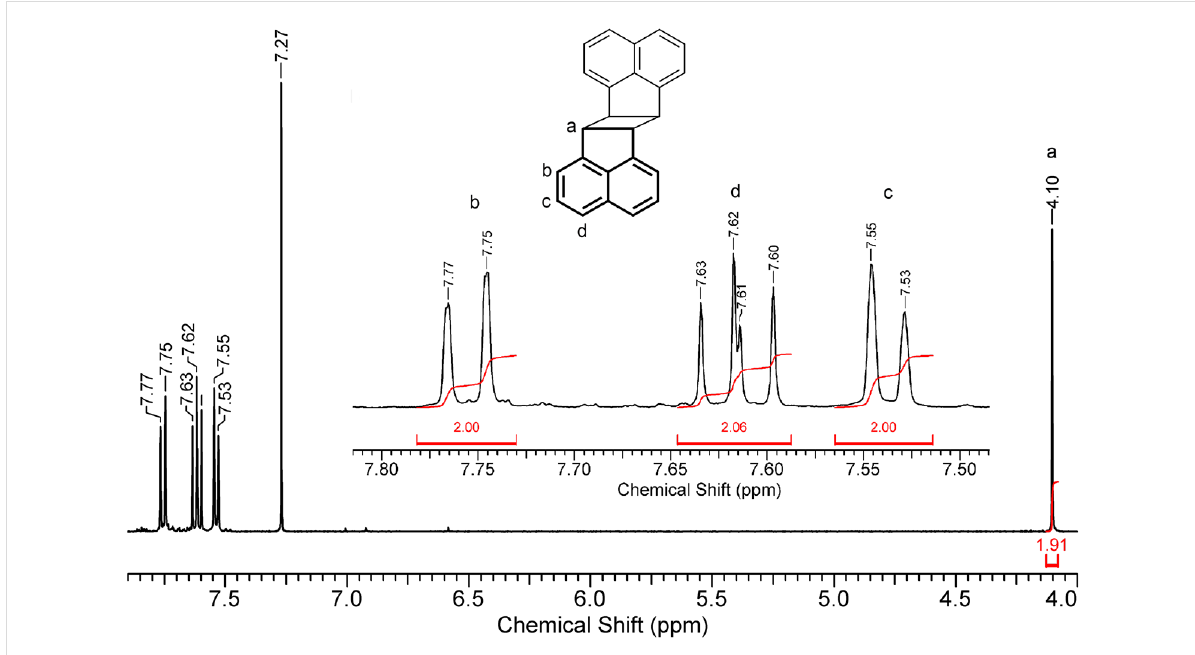
Figure 3: 1 H NMR spectrum of the photo product of ACE in the presence of γ -CD thioether 3 in CDCl 3 .